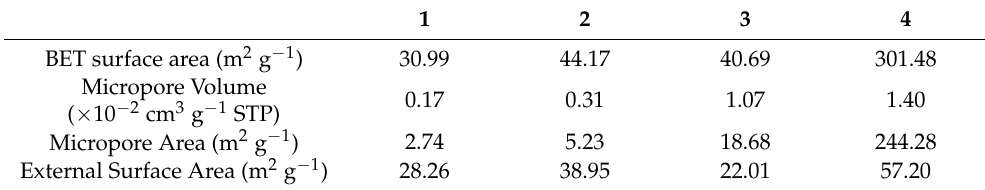
Table 3. BET results of 4 samples (1: clean clinoptilolite; 2: Zn 2+ -contaminated clinoptilolite; 3: clean zeolite A; 4: Zn 2+ -contaminated zeolite A).